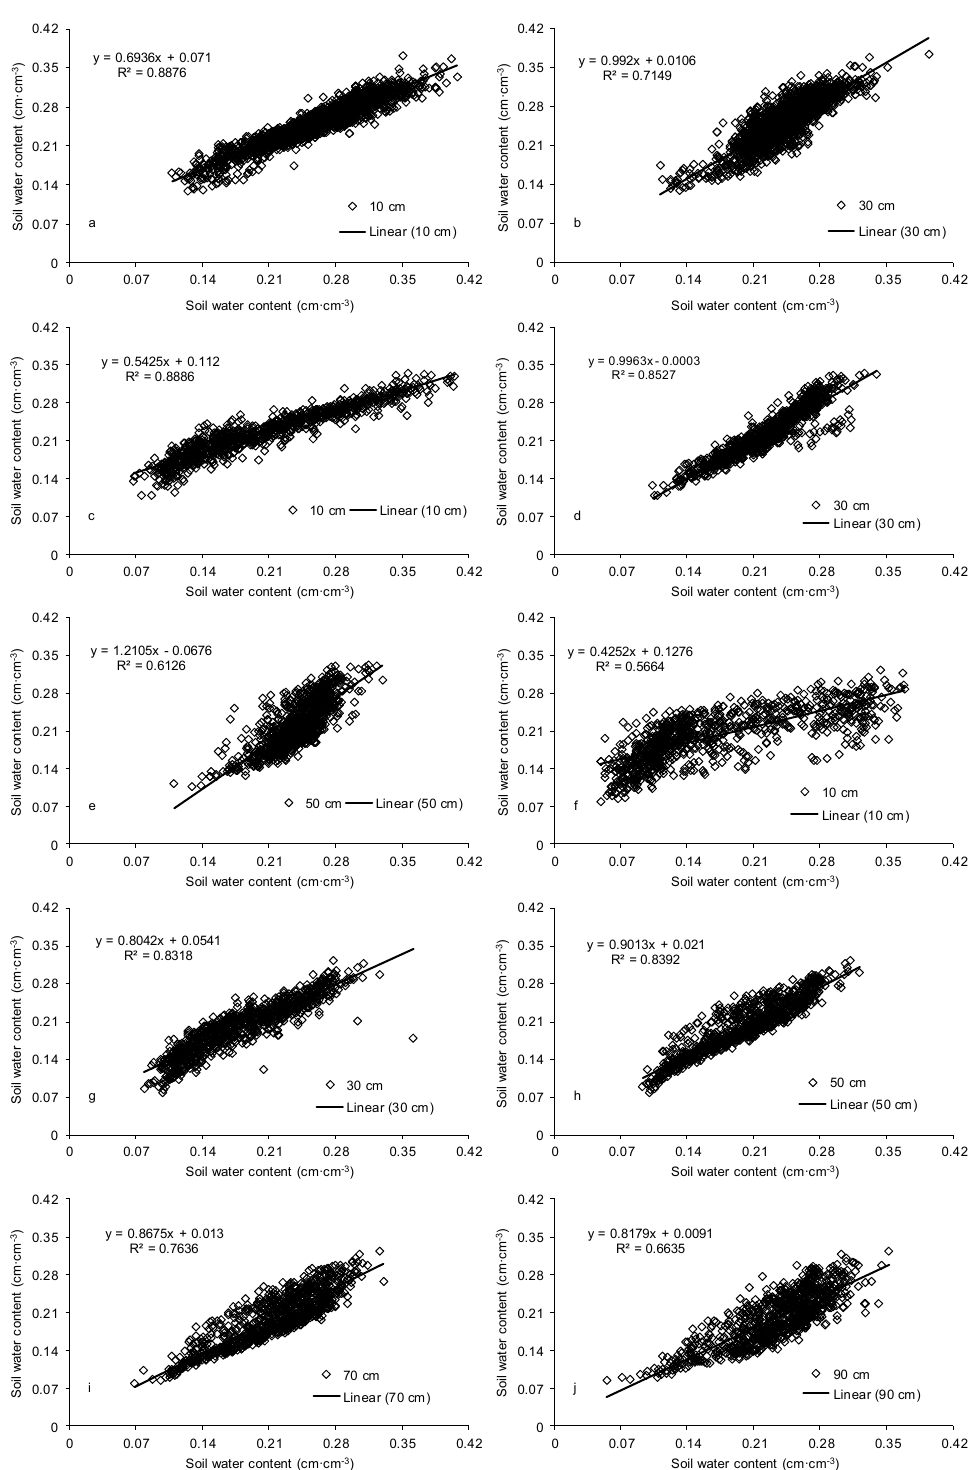
Figure 5. Relationship between average soil water content in planned wetted layers with soil water content at different depths in the soil profile during different growing stages of winter wheat: ( a , b ) early stage; ( c – e ) middle stage; and ( f – j ) last stage. Y -axis indicates average value of soil water content at 0–40 cm, X -axis indicates soil water content at 10 and 30 cm in ( a ) and ( b ), respectively. Y -axis indicates average value of soil water content at 0–60 cm, X -axis indicates soil water content at 10, 30, and 50 cm in ( c ), ( d ), and ( e ), respectively. Y -axis indicates average value of soil water content at 0–100 cm, X -axis indicates soil water content at 10, 30, 50, 70, and 90 cm in ( f ), ( g ), ( h ), ( i ), and ( j ),